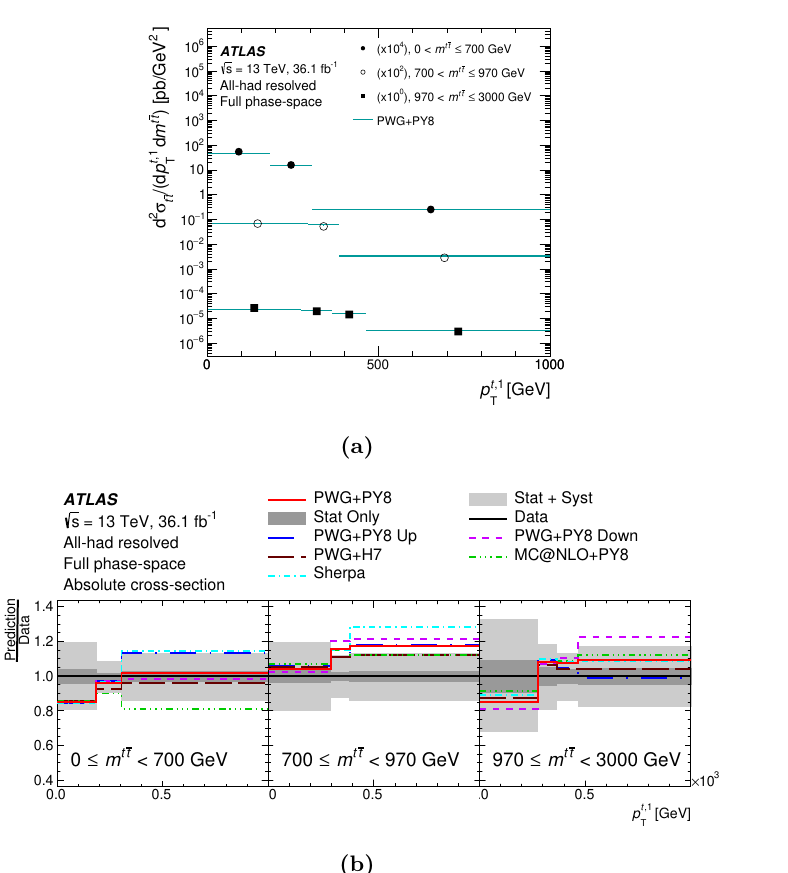
Figure 20 . Parton-level double-differential absolute cross-section (a) as a function of the lead- ing top-quark transverse momentum in bins of the t ¯ t system mass, compared with the nominal Powheg+Pythia 8 prediction without uncertainties. Data points are placed at the centre of each bin. Different markers are used to distinguish the three bins in m t ¯ t , while p t, 1 izontal axis. The ratio (b) of the measured cross-section to different MC predictions. Uncertainties are shown by the shaded